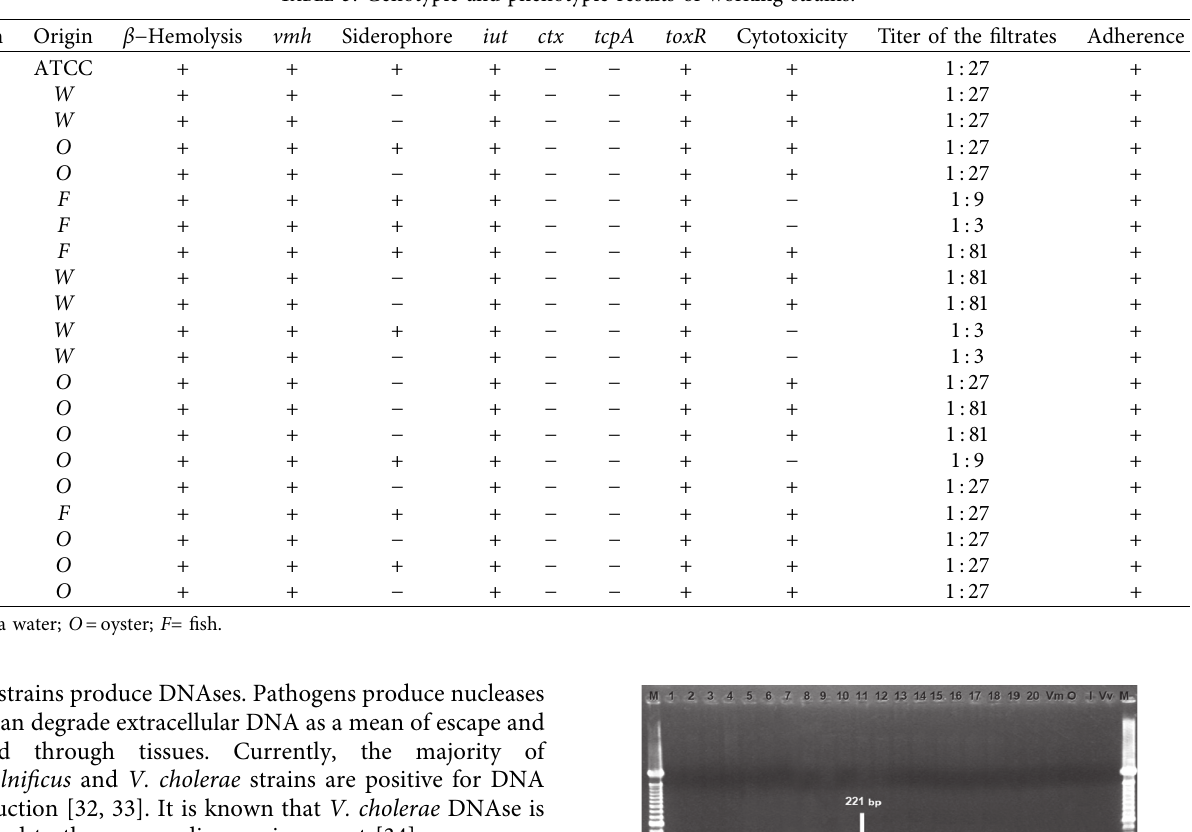
Table 3: Genotypic and phenotypic results of working strains.